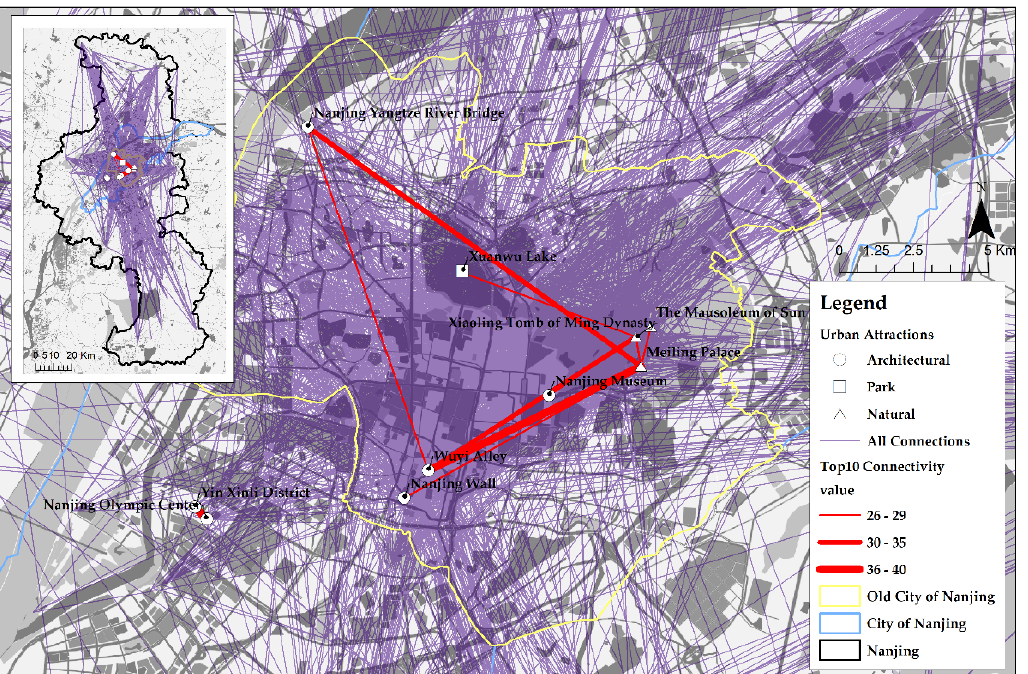
Figure 7. The new tourist routes with Changes after the outbreak in Nanjing.